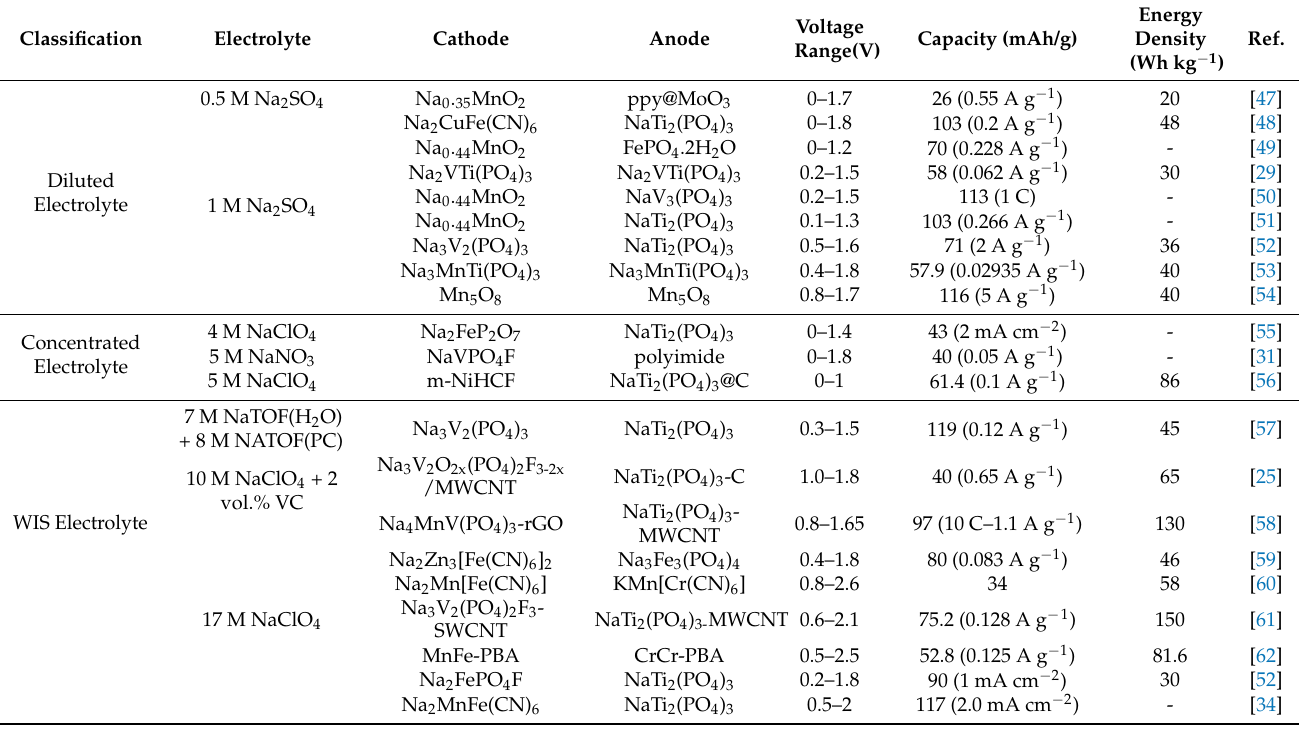
Table 1. Full cell systems for